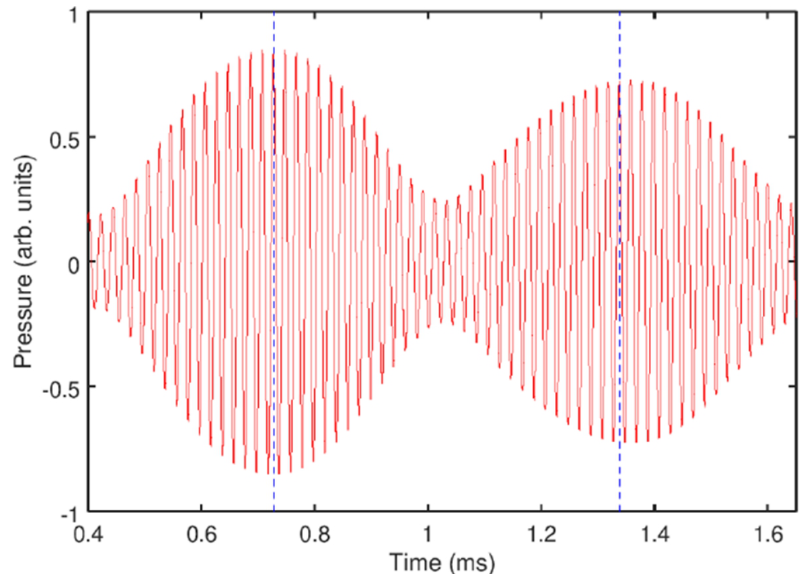
Figure 15. Measured acoustic bubble response corresponding to a sinusoidal driving pressure wave with the frequency f 0 = 49.2kHz (twice the frequency in Figure 14a) and amplitude α = 4.3kPa. Reproduced from [21] published by Springer Nature under the terms of the Creative Commons CC BY